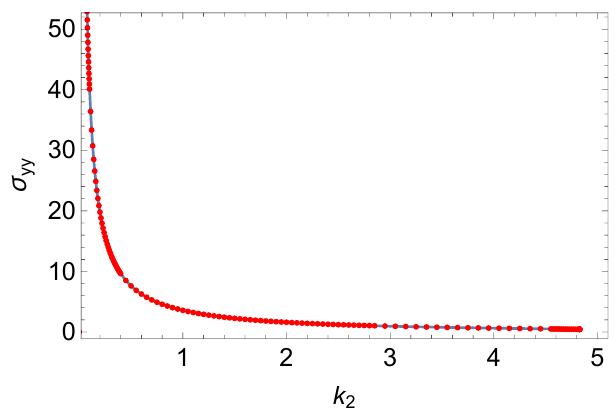
Figure 2 . The DC conductivity (cid:27) yy in terms of parameter k 2 , for (cid:12)xed p 1 = 1, and k 1 = 0 : 1. The red dots are from Kubo formula, and they match to the result(blue curve) obtained from the membrane paradigm in